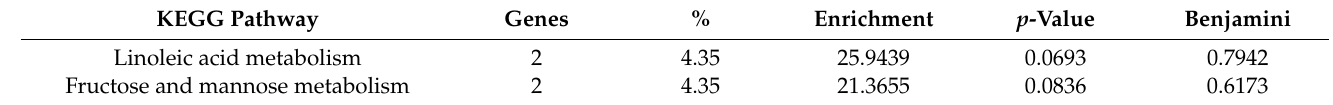
Table 4. Enriched gene ontology categories in transcripts of gastric cancer vs. chronic atrophic gastritis. KEGG Pathway Genes % Enrichment p -Value Benjamini Linoleic acid metabolism 2 Fructose and mannose